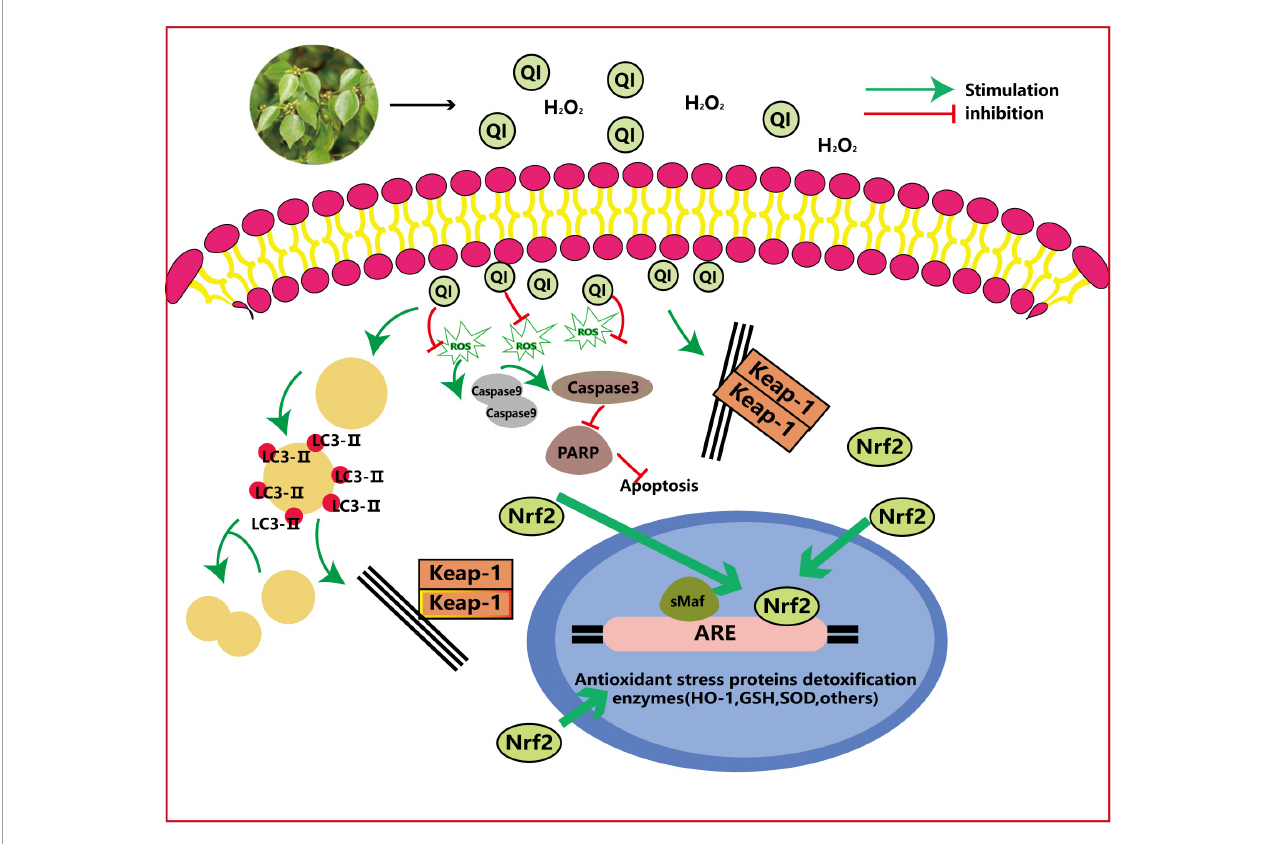
FIGURE7 Anti-oxidant mechanism of action of QI: QI induces major cellular anti-oxidant enzymes to trigger autophagy via Nrf2 activation and Nrf2-dependent and effectively attenuates H 2 O 2 -induced oxidative stress in HUVEcs. ROS, reactive oxygen species; Lc, light chain; Keap1, Kelch-like EcH-associated protein 1; PARP, poly (AdP-ribose) polymerase; ARE, antioxidant response element; GSH,